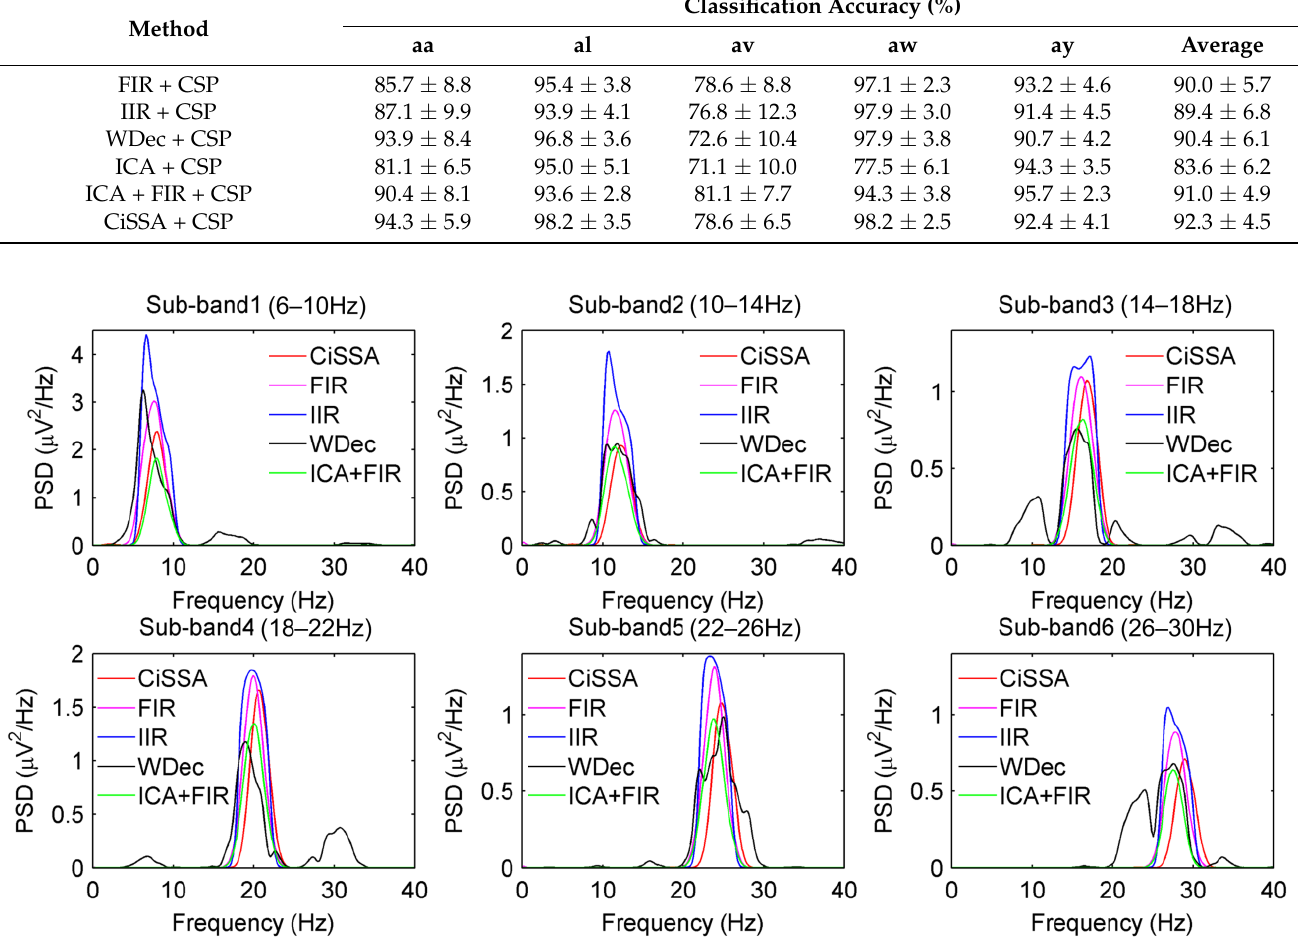
Table 3. The classification accuracies of CiSSA + CSP methods on different bandwidths on BCI Com- petition III dataset IVa (subject aa, al, av, aw, and ay).